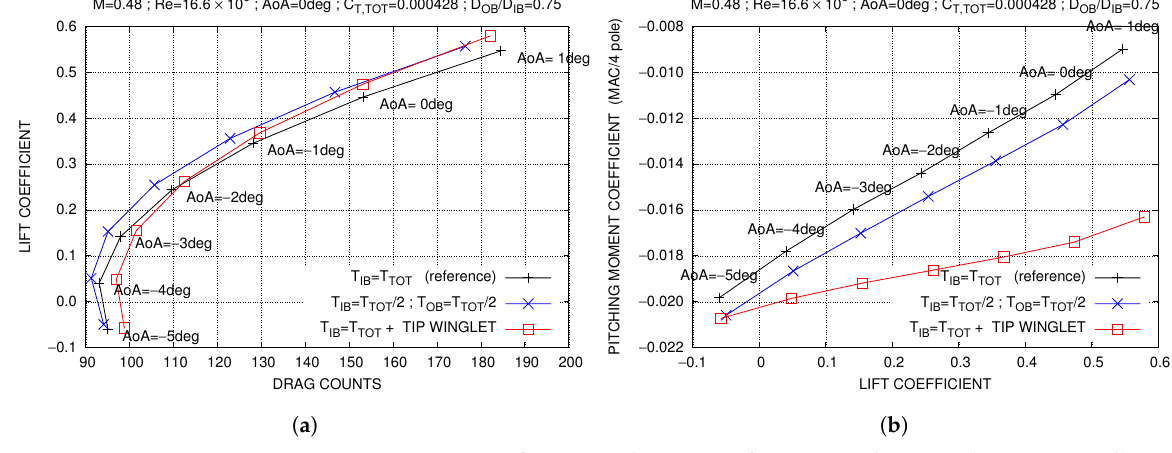
Figure 27. Comparison of wing aerodynamic performance with tip winglet or tip propeller, against ref- erence configuration, in cruise flight conditions: ( a ) Drag polar curves; ( b ) Pitching moment polar curves with pole at quarter mean aerodynamic chord.